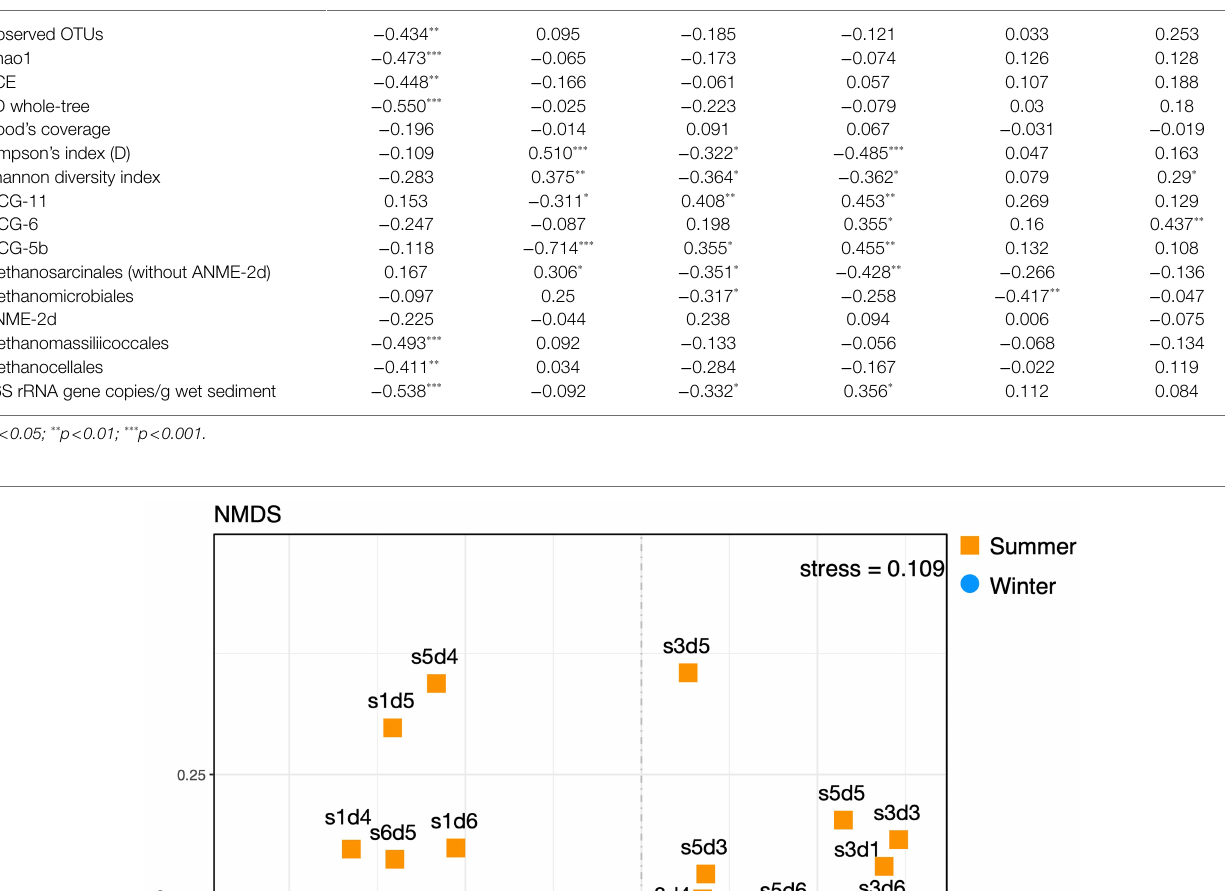
content, pH, and depth were significantly correlated with Bathyarchaeota. A RDA based on euryarchaeotal orders and bathyarchaeotal subgroups ( Figure 7 ) showed that the first two axes of the plots, respectively, explained 80.1 and 13.99%